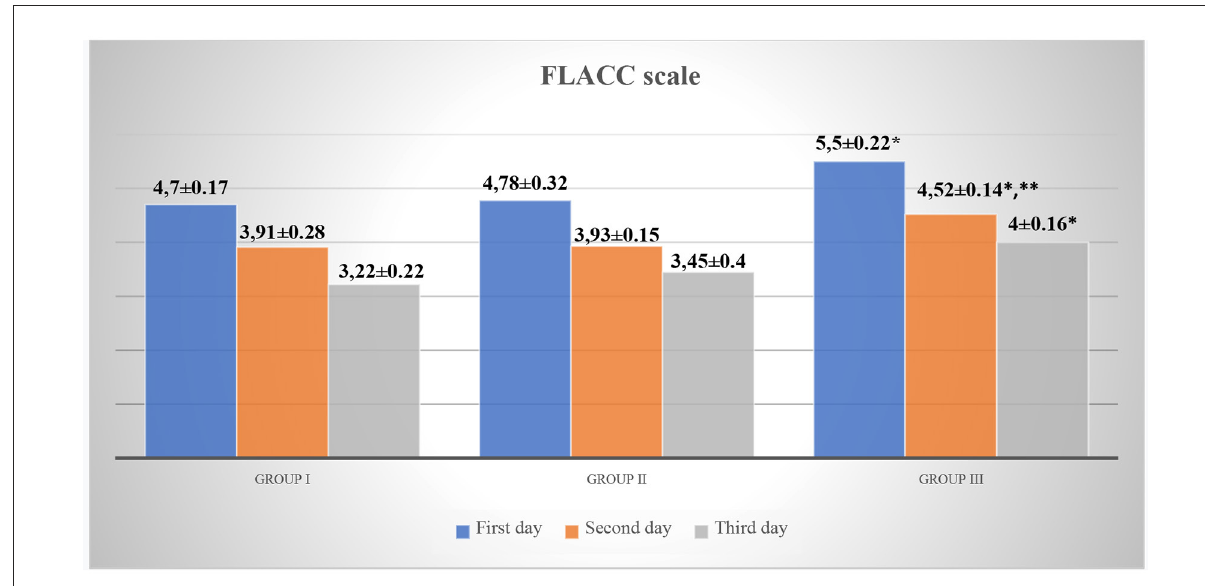
FIGURE2 FLACC scale for acute pain assessment in patients. * p < 0.05—a significant difference between children in Group III and Group I. ** p < 0.05—a significant difference between children in Group III and Group II.